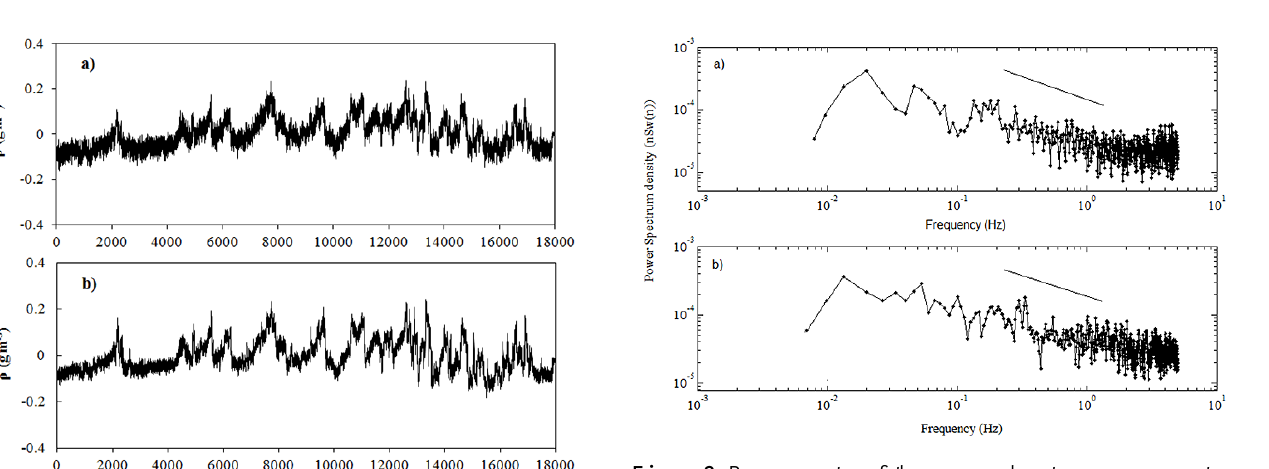
Figure 2. Power spectra of the measured water vapor concentra- tion by the open- (a) and closed-path gas analyzer (b) , where n is non-dimensional frequency. The solid lines indicates − 2/3 spectral decay for